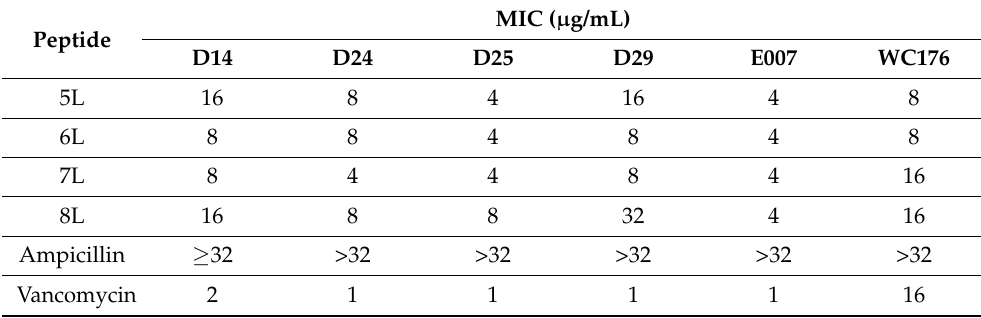
Table 3. MIC ( µ g/mL) of selected bovine lactoferrin peptides against E. faecium clinical